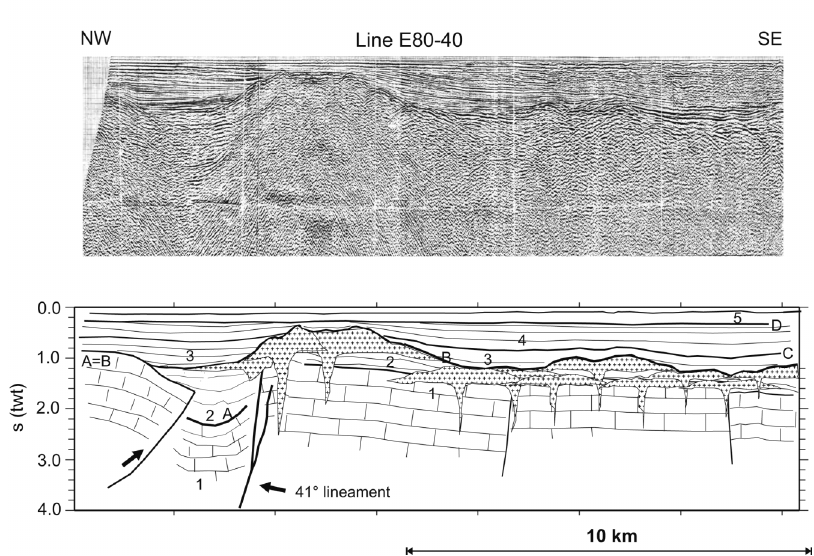
Fig. 3. E80-40 multichannel line and interpretation. Location in fig. 2. Legend: 1 – Mesozoic carbonates; 2 – Miocene Flysch terrains; 3 – Early Pleistocene marine or transitional sediments; 4 – Middle Pleistocene deltaic and possibly marine and volcanoclastic sediments; 5 – Late Pleistocene-Holocene transitional, marine and vol- canoclastic sediments. A – seismic erosional non depositional unconformity at the top of mesozoic carbonates. B – Time transgressive unconformity locally coinciding with the top of Unit 1 or Unit 2 or volcanic-igneous bod- ies. The 41° tectonic lineament is here interpreted as strike-slip fault. Note the absence of subsurface volcanism north of this